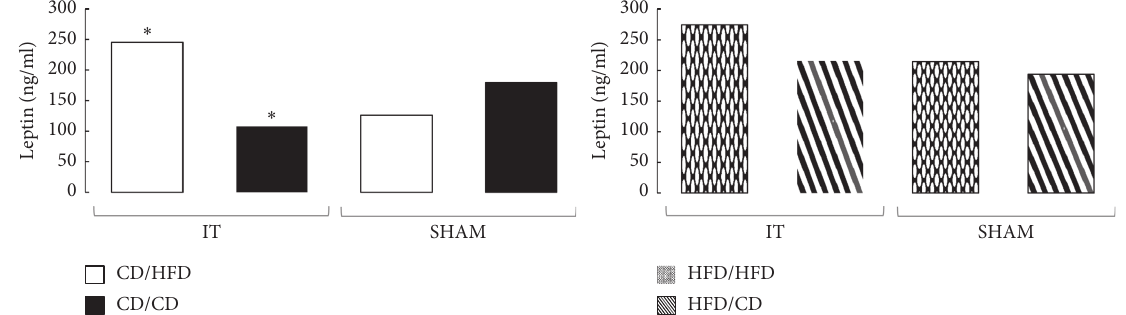
Figure 5: Median of leptin plasma concentration in four diet groups according to operation type. Abbreviations: IT—ileal transposition, SHAM—sham operated animals, CD—control diet, and HFD—high-fat diet. Preoperative diet/postoperative diet: CD/HFD, CD/CD, HFD/ HFD, HFD/CD (group size: n � 6, except IT HFD/HFD: n � 5). Sign ∗ denotes significant difference between median values; Kruskal–Wallis test, p < 0 . 05. Quartile deviation (Q25 and Q75) available in Supplementary